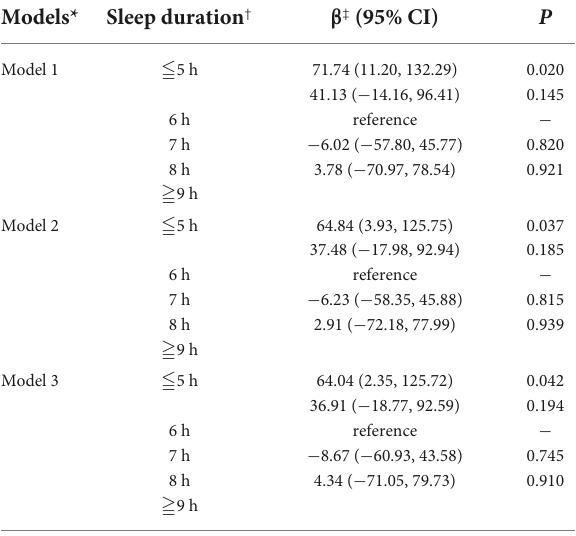
TABLE 2 Association between different sleep duration and immunoglobulin E (IgE) level. Models*